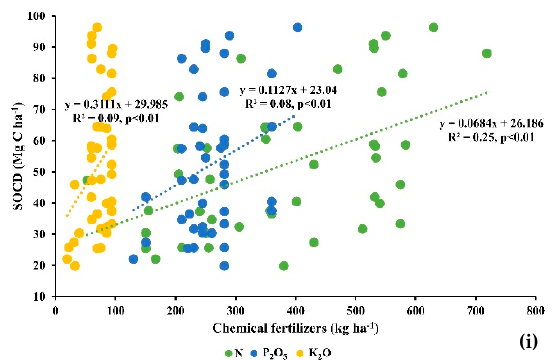
Figure 4. Relationship between SOCD and chemical fertilizers: ( a ) cabbage; ( b ) upland rice; ( c ) lowland rice; ( d ) tomato; ( e ) strawberry; ( f ) potato; ( g ) Japanese pumpkin; ( h ) cape gooseberry; ( i ) maize.